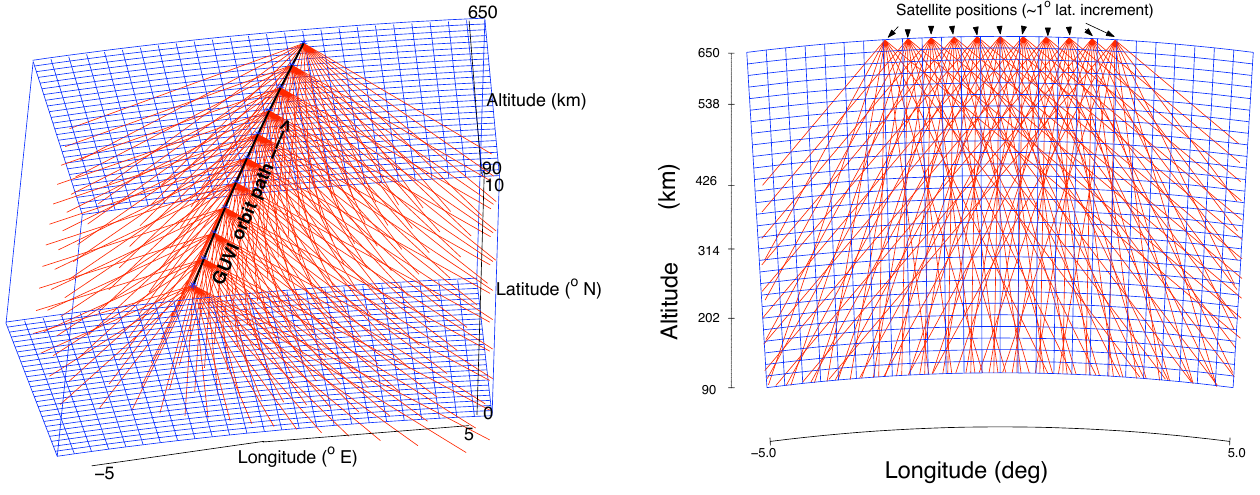
Fig. 2. GUVI 3-D observation geometry (left) and resulting 2-D tomographic Fig. 3. GUVI 3D observation geometry (left) and Resulting 2D tomographic observations.